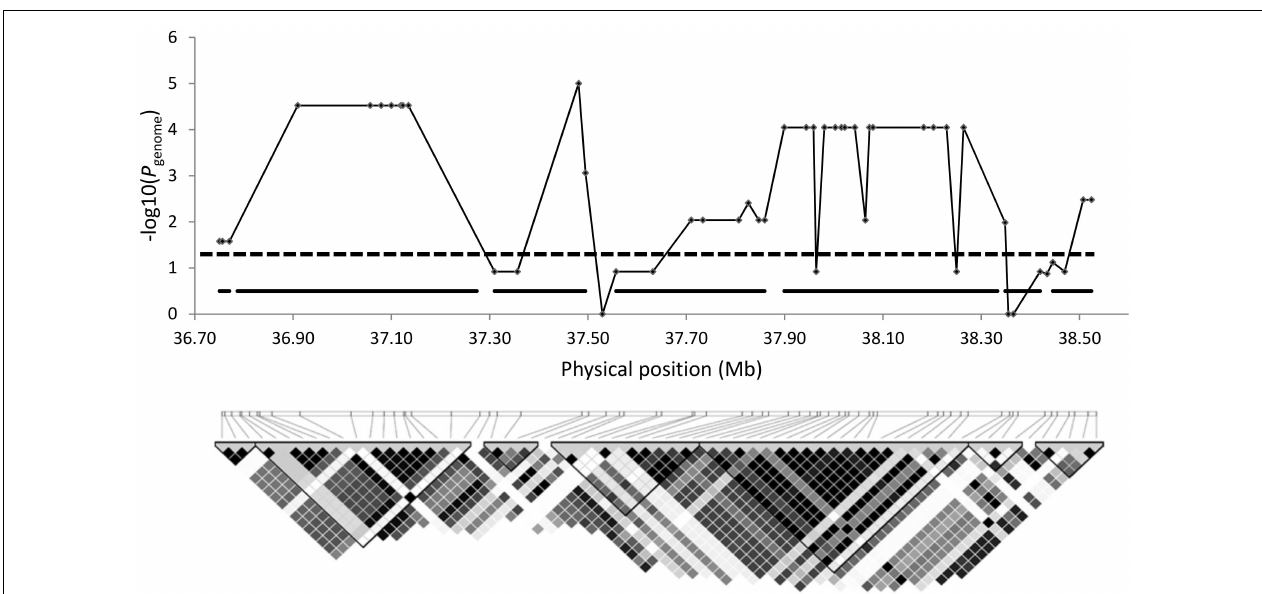
2011), as seen in TableA4 in Appendix.The horizontal dotted line represents the threshold of genome-wide significance.The graphical representation of the LD pattern across the region is generated in Haploview 4.2. LD is specified using the r 2 -color scheme: r 2 = 0: white; 0 < r 2 < 1: shades of gray; r 2 = 1: black.The black horizontal lines in the Manhatten plot correspond to the position of the LD blocks defined in Haploview.